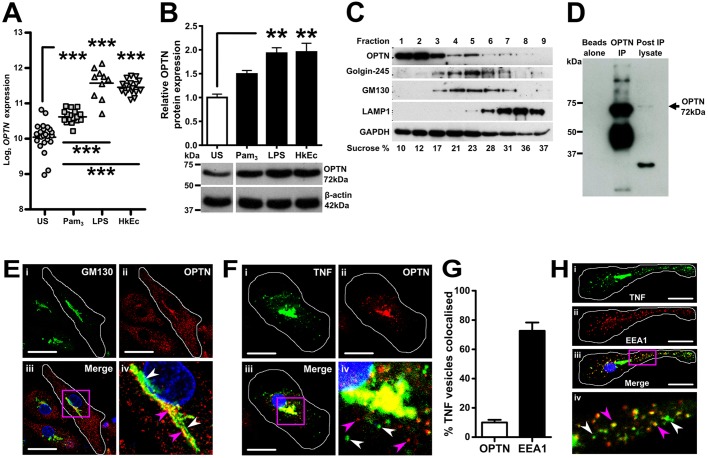
OPTN is upregulated and colocalises with TNF at the Golgi complex upon bacterial stimulation in macrophages. (A) OPTN expression in MDMs stimulated with Pam3 (TLR2), LPS (TLR4) and HkEc compared to unstimulated (US) MDMs (n=10-23/group). (B) Immunoblot for OPTN in MDMs after TLR2, TLR4 and HkEc stimulation (n=4). (C) Subcellular fractions of HkEc-stimulated THP-1 cells were immunoblotted for OPTN and markers for the Golgi complex (golgin-245 and GM130), lysosomes (LAMP1) and cytosol (GAPDH). (D) Immunoblot for OPTN after immunoprecipitation of OPTN from THP-1 cells. (E) Confocal microscopy in an MDM (white outline) stimulated with HkEc for 4 h were stained for GM130 (i) and OPTN (ii). Single-stained GM130 Golgi complex (white arrowheads) and double-stained OPTN and GM130 (pink arrowheads) are visible (iv). (F) Confocal microscopy in an MDM (white outline) stimulated with HkEc for 4 h were stained for TNF (i) and OPTN (ii), which colocalised within the Golgi complex (iii). Single-stained OPTN vesicles (pink arrowheads) and TNF vesicles (white arrowheads) are visible (iv). (G) Quantification of TNF vesicles that colocalised with OPTN and EEA1 (n=8-16 cells/person, 2 persons performed). (H) Confocal microscopy in an MDM (white outline) stimulated with HkEc for 4 h were stained for TNF (i) and early endosome antigen 1 (EEA1) (ii). Double-positive peripheral vesicles (pink arrowheads) and single-positive TNF vesicles (white arrowheads) are shown (iv). Results shown are mean±s.e.m., quantified immunoblots are normalised to actin (**P<0.01 and ***P<0.001; one-way ANOVA and Bonferroni's test for multiple comparisons). All images were taken with a 63× oil-immersion objective. Scale bars: 20 µm.